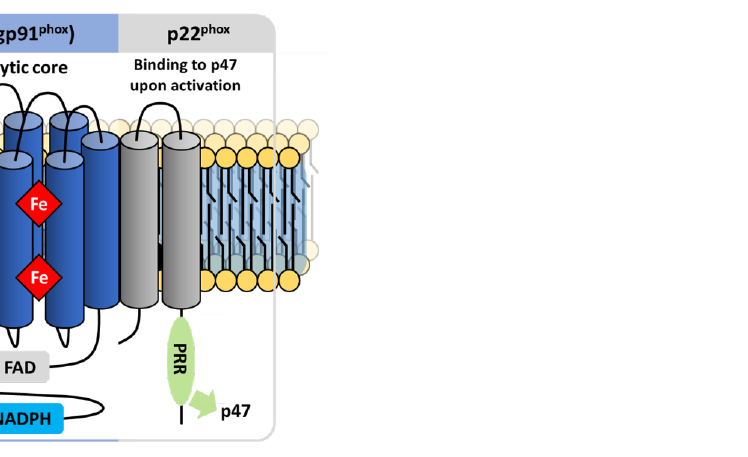
Figure 2. Catalytic subunit of the NADPH phagocyte oxidase complex. NOX2 topology harbors 6 membrane-spanning helices inter-connected by intra and extracellular loops, as well as a cytosolic domain enclosing FAD and NADPH-binding domains. Helices 3 and 5 of NOX2 chelate two b-type heme groups. Despite various studies, the number of transmembrane segments of p22 phox is not clearly identified, and the protein has thus been represented in this review with 2 helices and a C-ter cytosolic segment presenting a PRR domain that interacts with the cytosolic factor p47 phox . Table 1. Main features shared among the NADPH oxidase family of